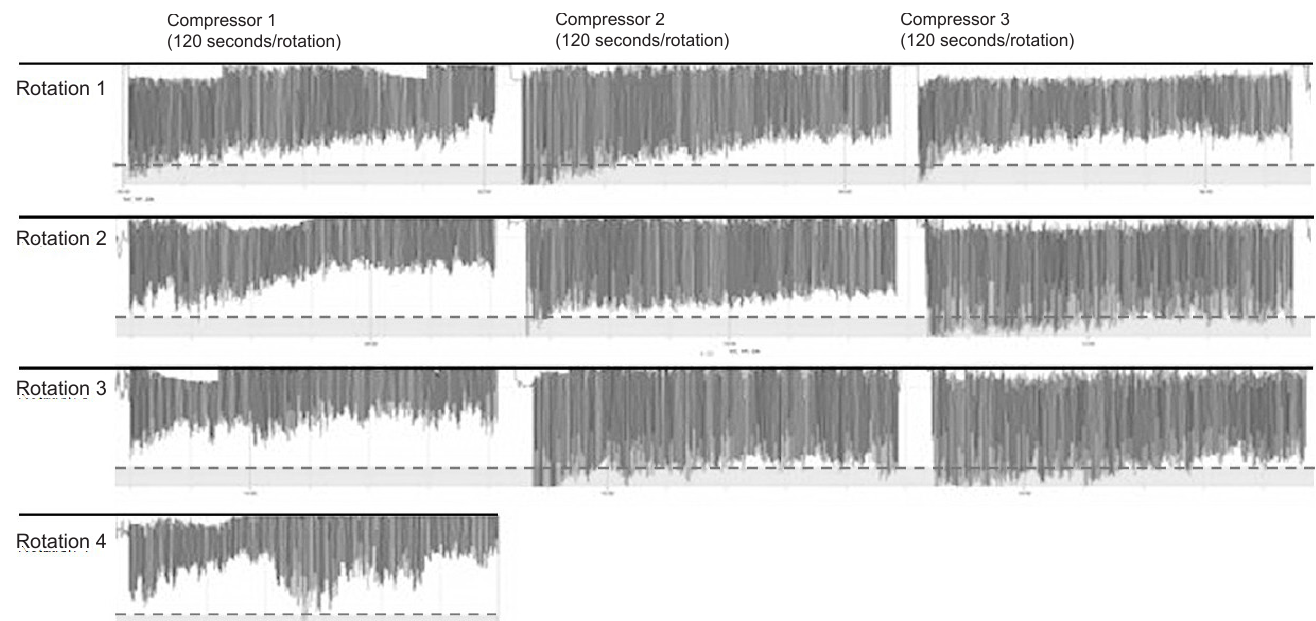
Figure 1. Composite screen-capture image of chest compression dataset visualization for a 3-compressor team’s 20-minute study session, starting at left with time progression to the right and downward. Compression plots for each member of the team are displayed in columns; compression plots for each 3-compressor rotation are displayed in rows. Note the generally inadequate compression depth (appropriate depth indicated by dashed bars), frequency of inadequate chest release (leaning), progressive reduction in compression depth within each compressor’s rotation, as well as the between-compressor and within-compressor variability in compression